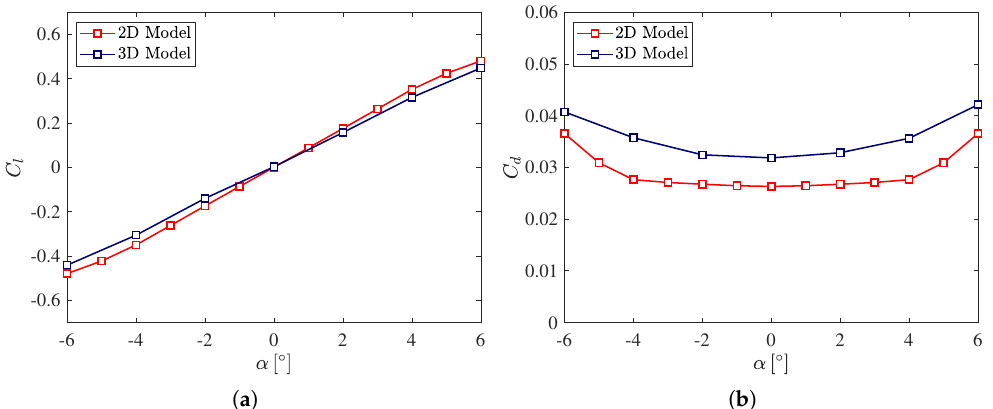
Figure 20. Comparison between polar diagrams of the 2D damaged airfoil and the 3D eroded blade. ( a ) Comparison of the lift coefficient distribution as a function of the angle of attack; ( b ) Comparison of the drag coefficient distribution as a function of the angle of